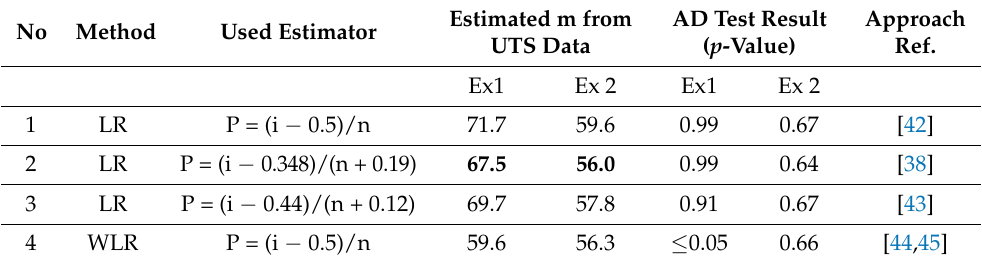
Table 4. The Anderson–Darling (AD) goodness of fit test for m calculated by unweighted linear regression (LR) or weighted linear regression (WLR) with different estimators. Already presented values are marked by bold